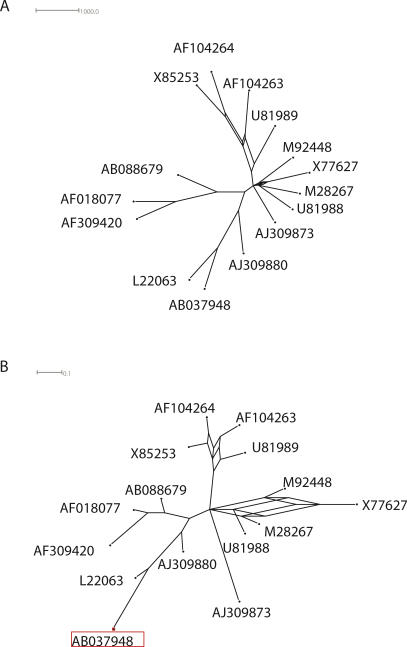
Two Consensus Networks for the HDV Dataset Consisting of 15 Sequences of HDV RibozymesThe name of each sequence indicates the NCBI accession number of the strain (see also Figure 6). The edge lengths in the left network correspond to the probability of the corresponding split in the posterior distribution, whereas the edge lengths in the right network correspond to the average length of the edge in the sampled trees.